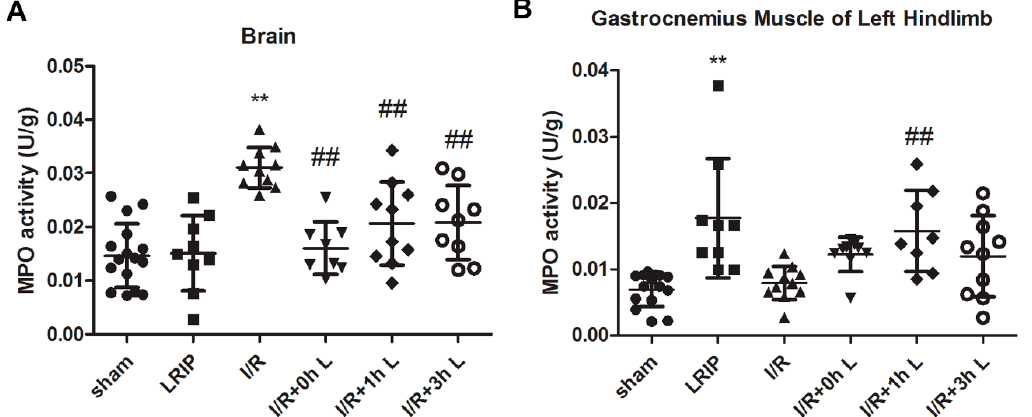
Figure 2. Effects of LRIP on neutrophil infiltration in the brain and left hindlimb gastrocnemius muscle: Myeloperoxidase (MPO) activities in: the brain ( A ); and left hindlimb gastrocnemius muscle ( B ) were assessed at 24 h after reperfusion. Data are expressed as mean ± SD, n = 6, ** p < 0.01 vs. sham group, ## p < 0.01 vs. I/R group.